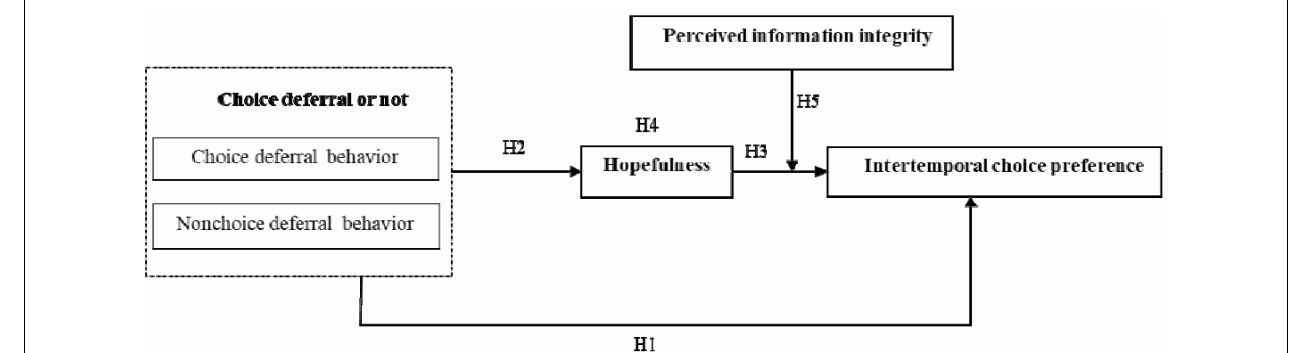
FIGURE 3 | Research model.